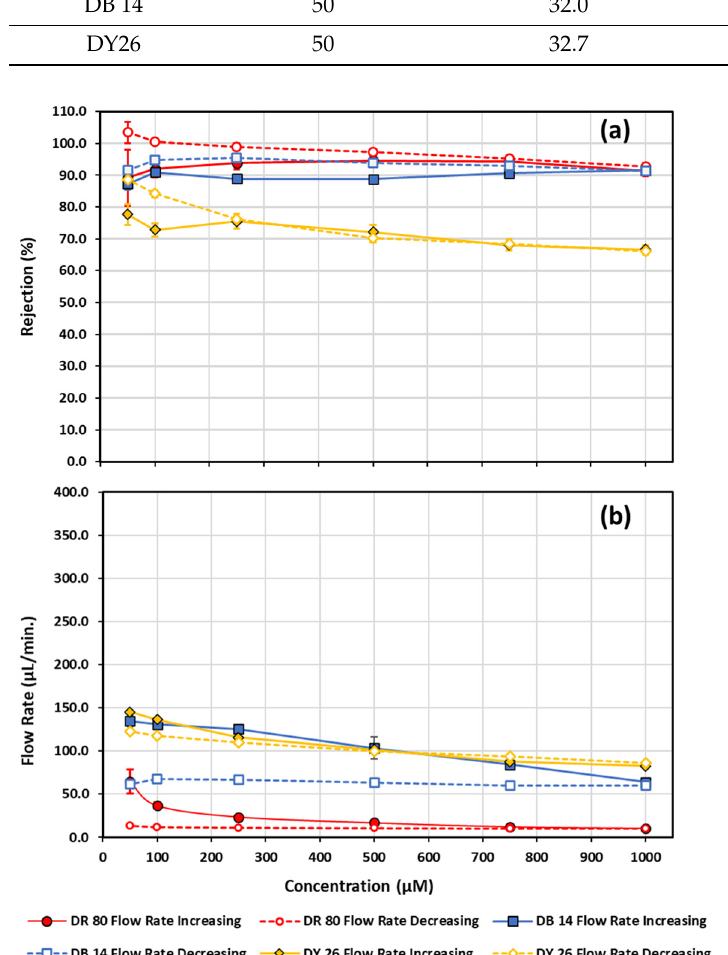
Figure 10. Rejection ( a ) and flow rate ( b ) measurements as a function of increasing and decreasing concentration for direct red 80, direct blue 14, and direct yellow 26. Closed data points connected by a solid line correspond to measurements made going from low to higher concentration, while open data points connected by a dashed line correspond to measurements made while going from high to lower concentration. Diamonds—direct yellow 26; squares—direct blue 14; circles—direct red 80.